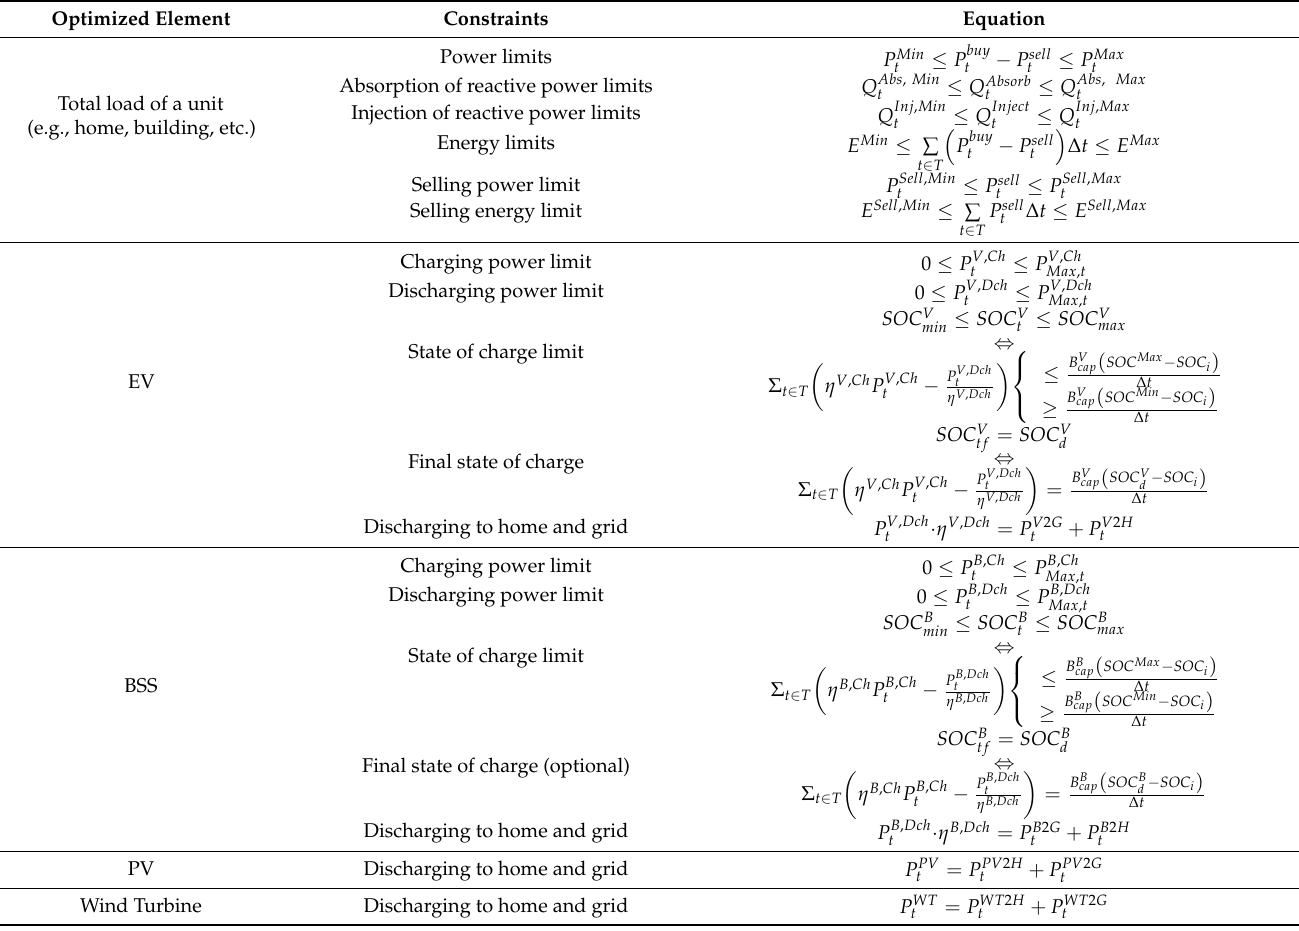
Table 10. Most used optimized elements and their